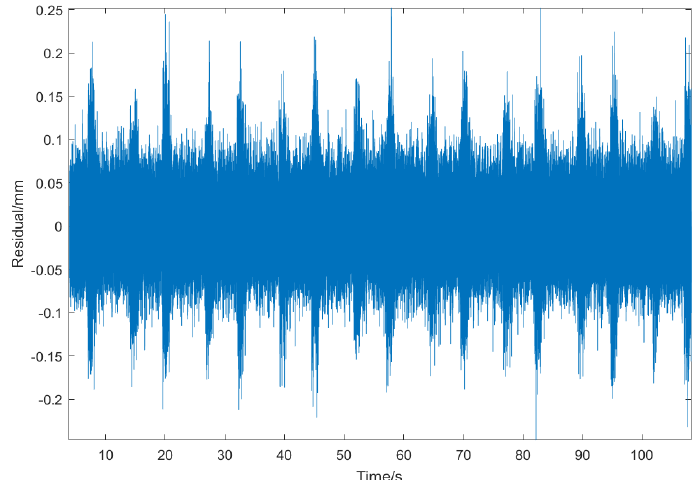
Figure 6. The residual during the operation.